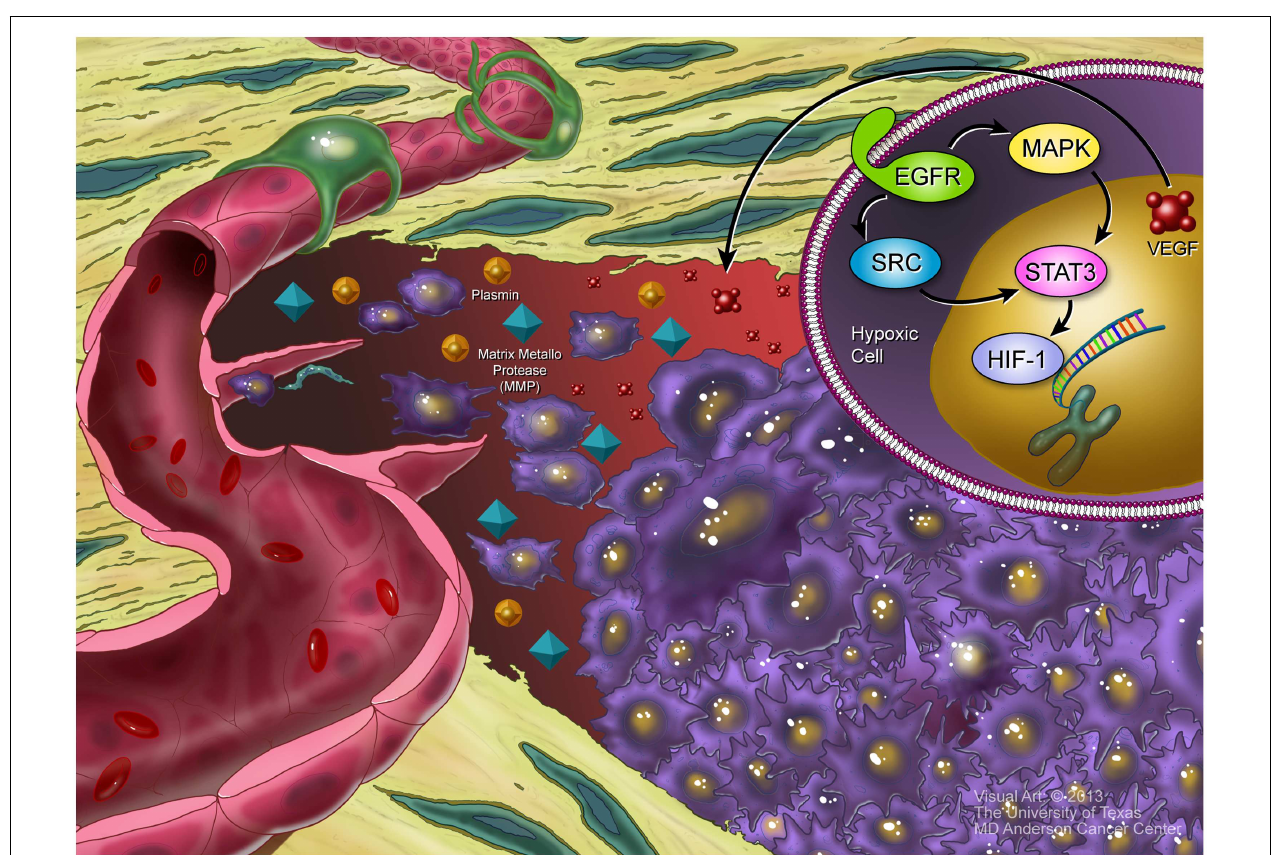
of MMPs and plasmin, which help mediate digestion of extracellular matrix proteins, facilitating migration of both endothelial cells and tumor cells. In response to theVEGF gradient, some endothelial cells acquire a “tip cell” phenotype, pushing long extensions toward the tumor.These tip cells will eventually form the new blood vessels that provide a blood supply to the growing